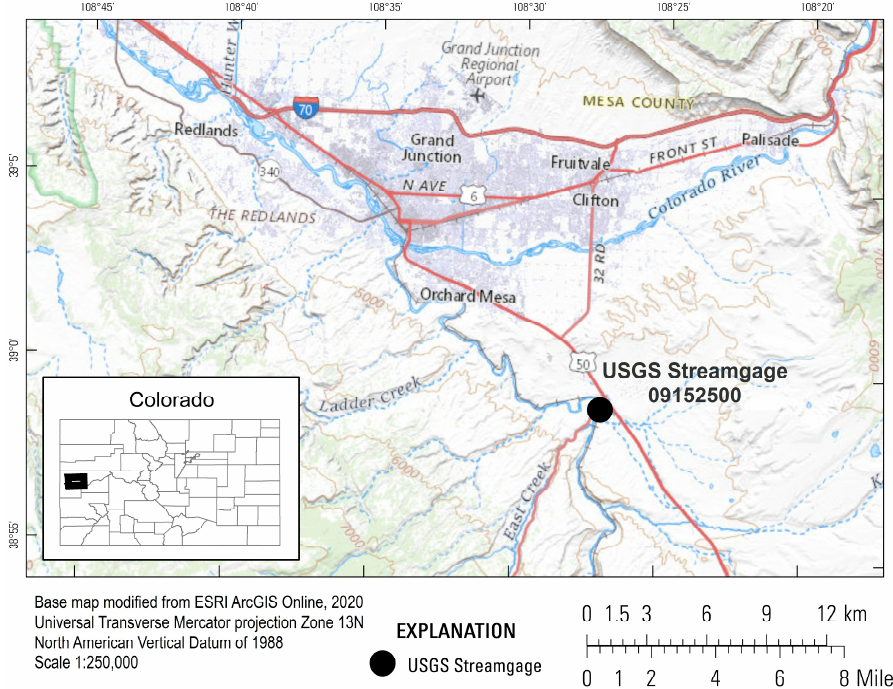
Figure 1. Map of the study site collocated with USGS streamgage (09152500) on the Gunnison River near Grand Junction, Colorado. Elevations reported in meters above North American Vertical Datum (NAVD 88).